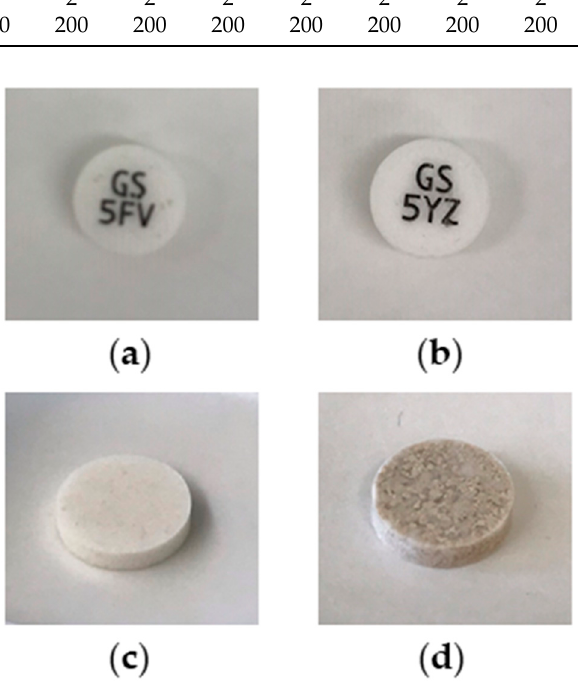
Figure 1. Tablet formulations of: ( a ) Wellbutrin ® XR 150 mg, ( b ) Wellbutrin ® XR 300 mg, ( c ) bupropion . HCl and ( d ) naltrexone . HCl.